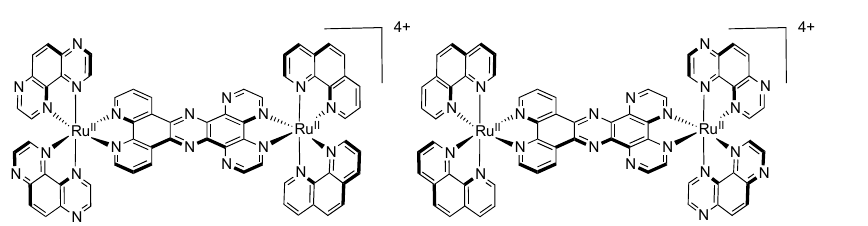
Figure 33. The complexes [Ru(TAP) (PHEHAT)Ru(TAP) [Ru(phen) 2